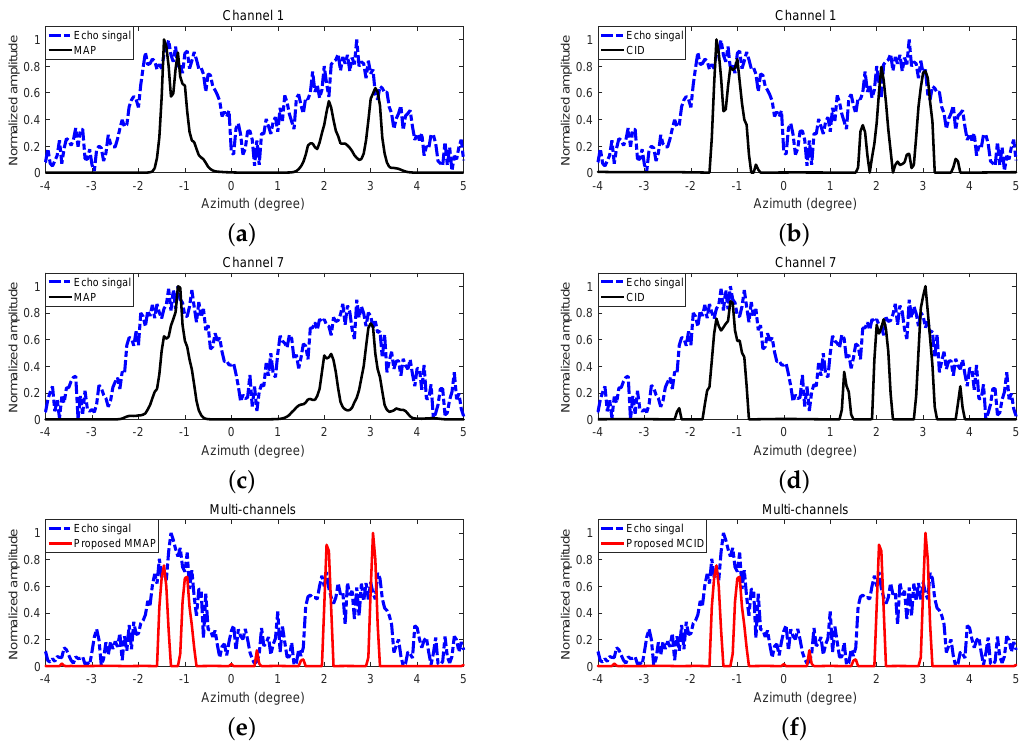
Figure 10. Received echo signal and super-resolution results when SNR = 10 dB . ( a , b ) MAP and CID of Channel 1; ( c , d ) MAP and CID of Channel 7; ( e ) Proposed MMAP; ( f ) Proposed MCID.